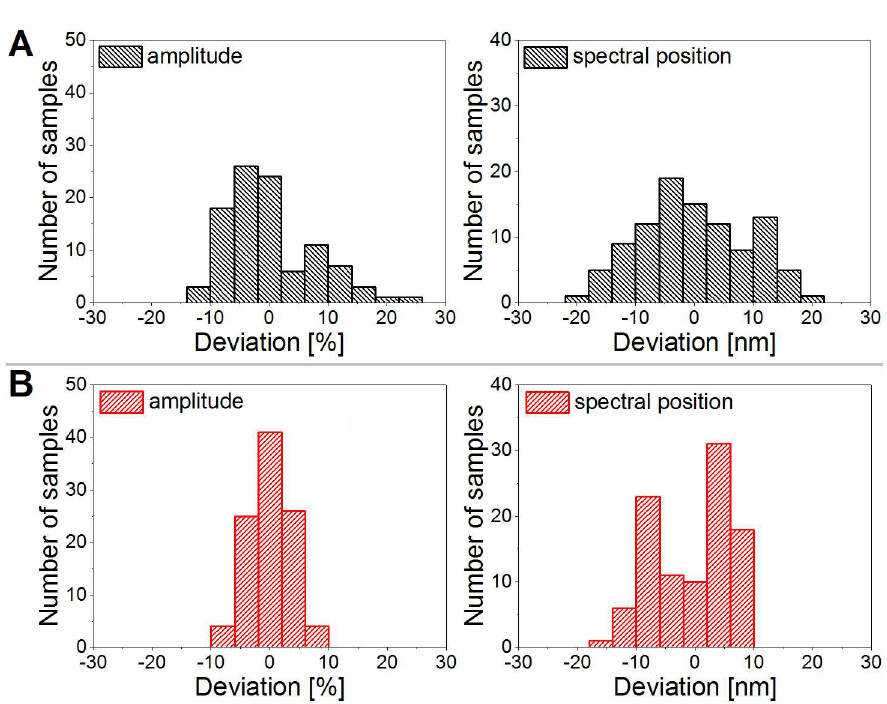
Fig 6. Histograms of amplitude and spectral position measuredby the two optical setups. (A) The perpendicular measurement graphs exhibita broaderscatter comparedto (B) the integratingsphereresults, indicating that the perpendicular illumination and detectionresults in highervariancein the case of textured opticalsurfaces (n = 100